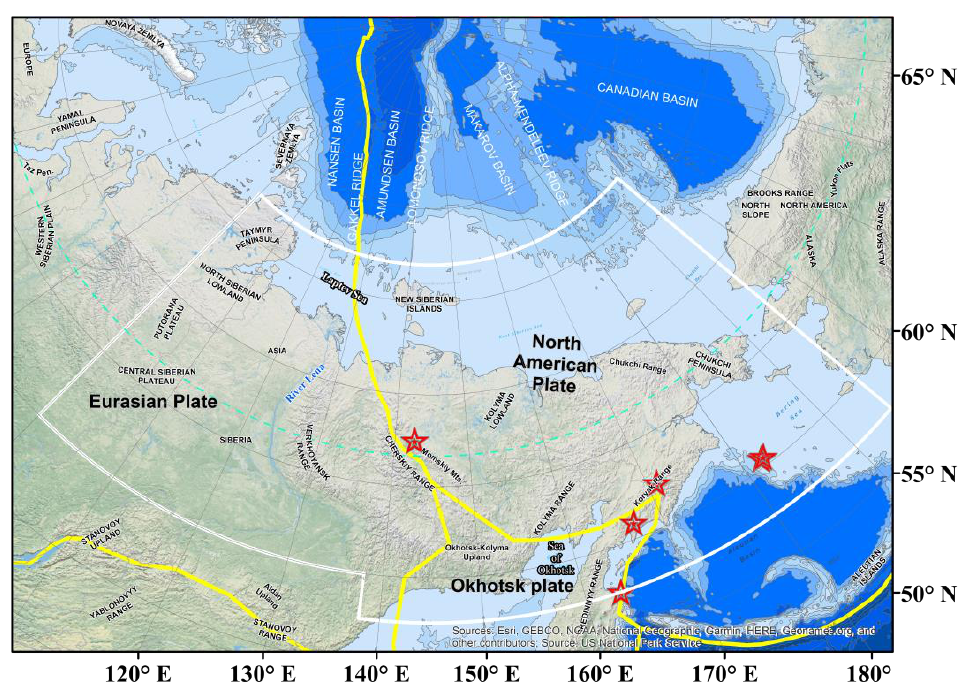
Figure 1. The main structures of the eastern sector of the Russian Arctic. The yellow line is the boundaries of tectonic plates, the light green dotted line is the polar circle, and the red stars are the epicenters of earthquakes with М ≥ 6.0 that occurred over the past two decades. The white frame shows the boundaries of the studied region.